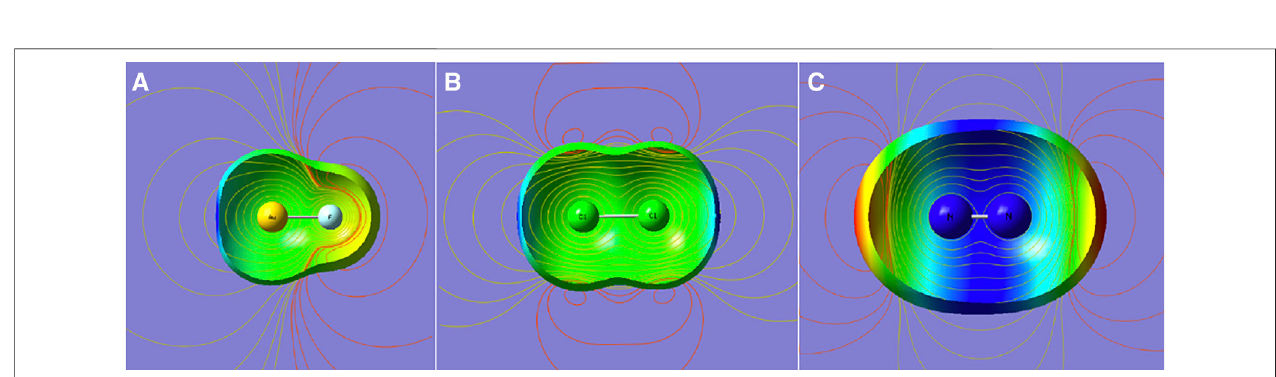
Three limited cases are presented in Figure 2 : a dipolar and two quadrupolar cases. It shows the contours of the electrostatic potential that emanate from a dipole and two quadrupoles of opposite signs. One may conclude that the positive “ σ hole ” in the left two and the negative “ σ bump ” offer no unique insights except for pointing to the sign of the leading surface shows an axial indentation, as in AuF in Figure 2 , the